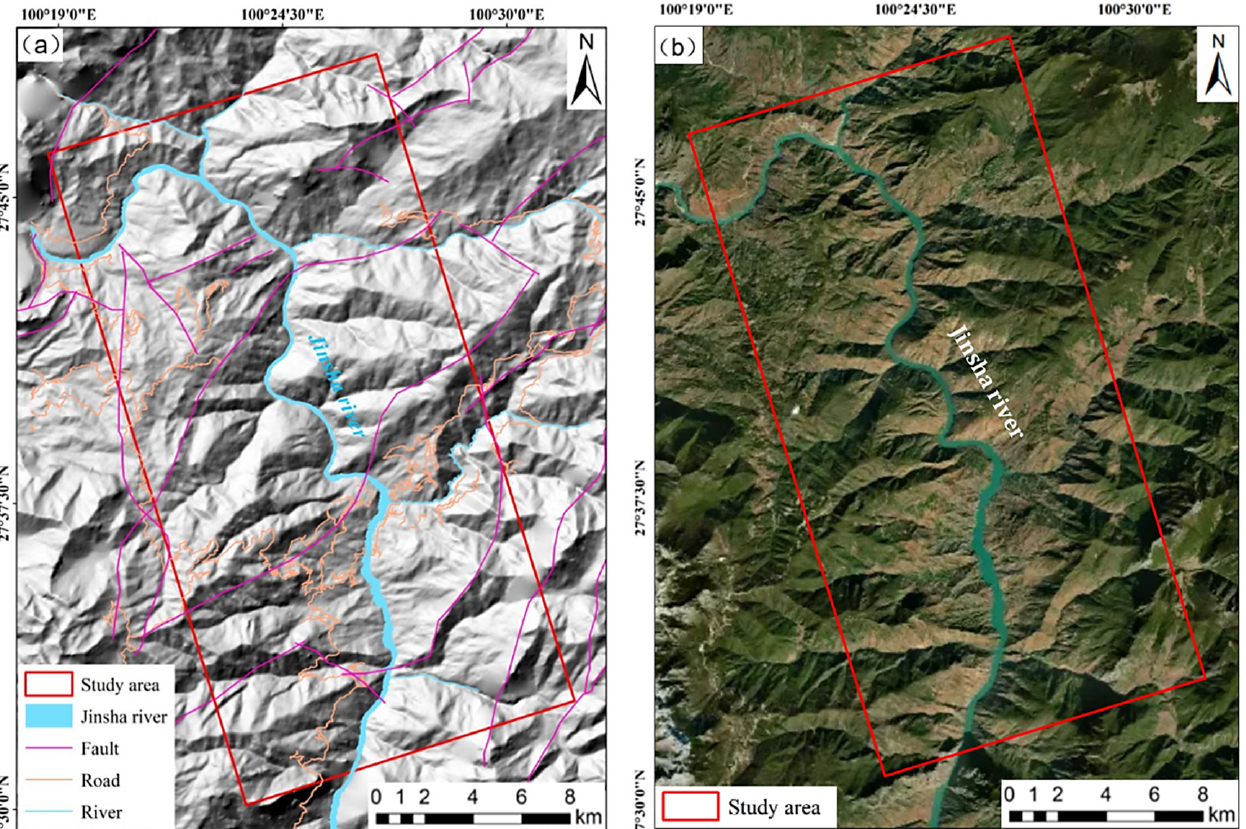
Figure 3. Topographic and optical imaging of the study area: ( a ) topography and ( b ) optical image.